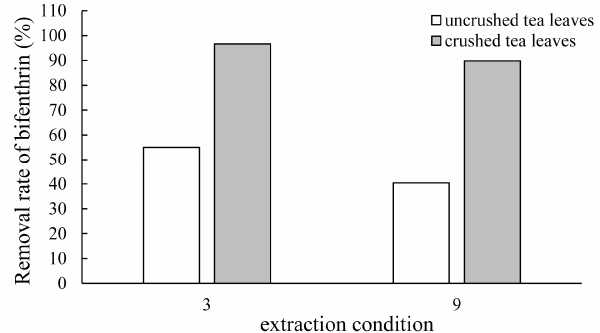
Figure 2. The extraction efficiency of bifenthrin of uncrushed tea leaves and crushed tea leaves. The numbers 3 and 9 in the horizontal axis represent the extraction condition numbered 3 and 9 in Table 5, respectively.